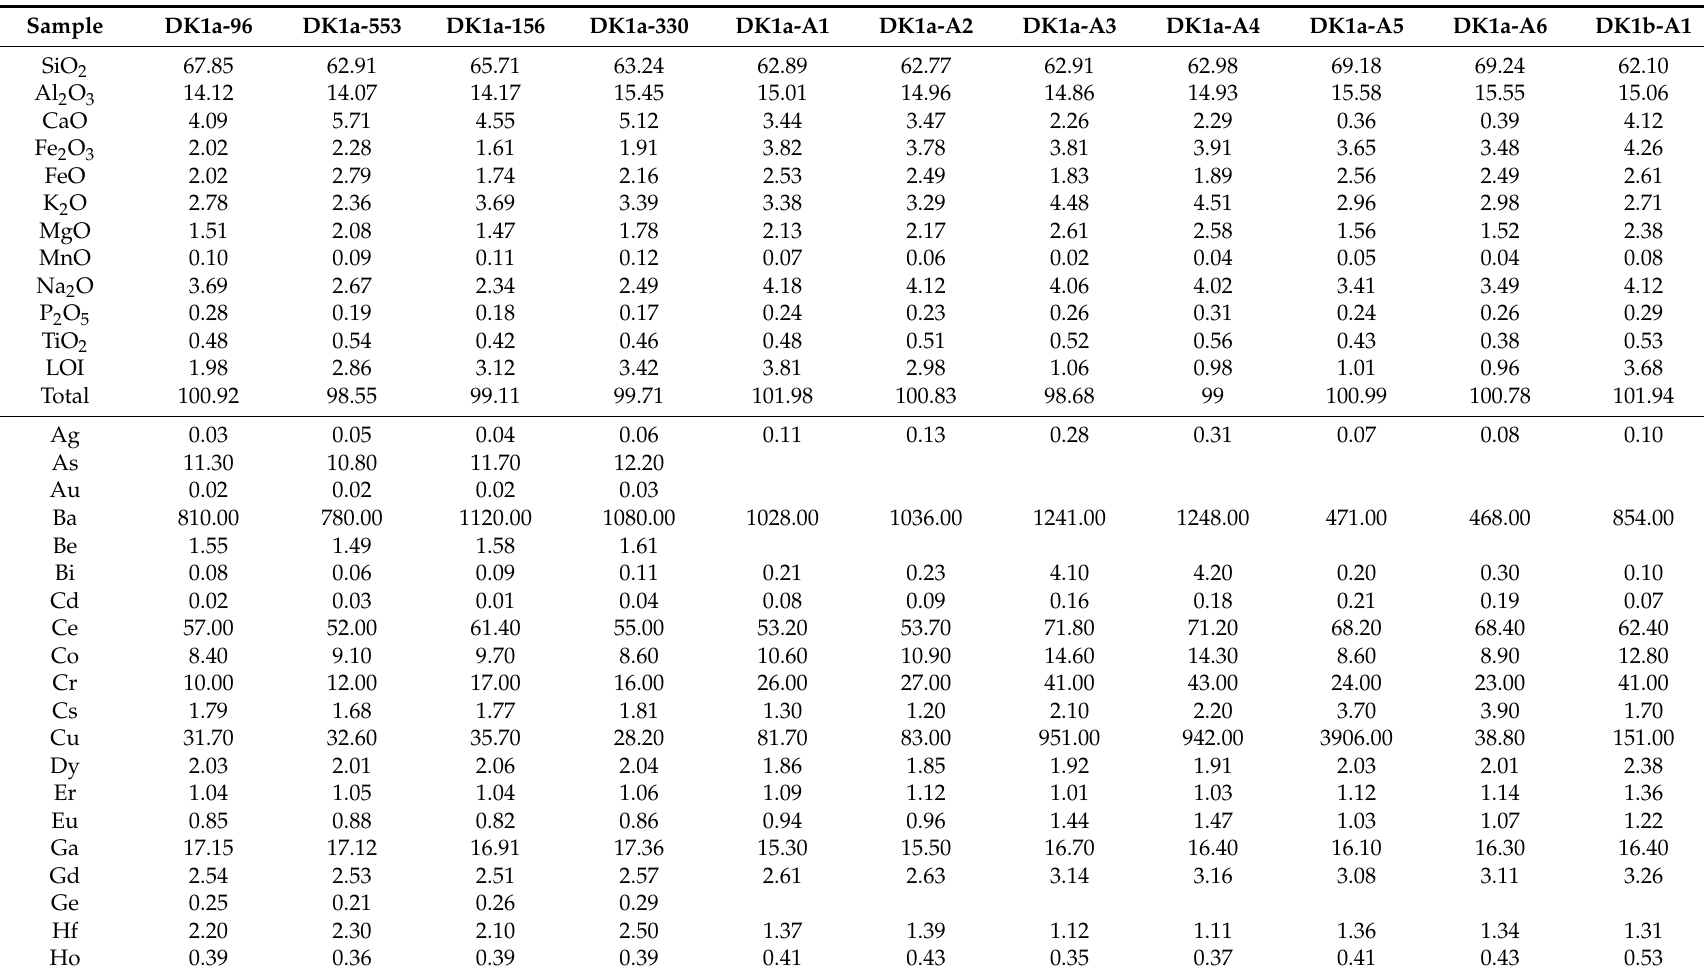
Table 4. Major oxide (wt %), trace element (ppm) compositions of dykes (DK1a, DK1b and DK1c) in the Sungun porphyry deposit ((A) analysis by